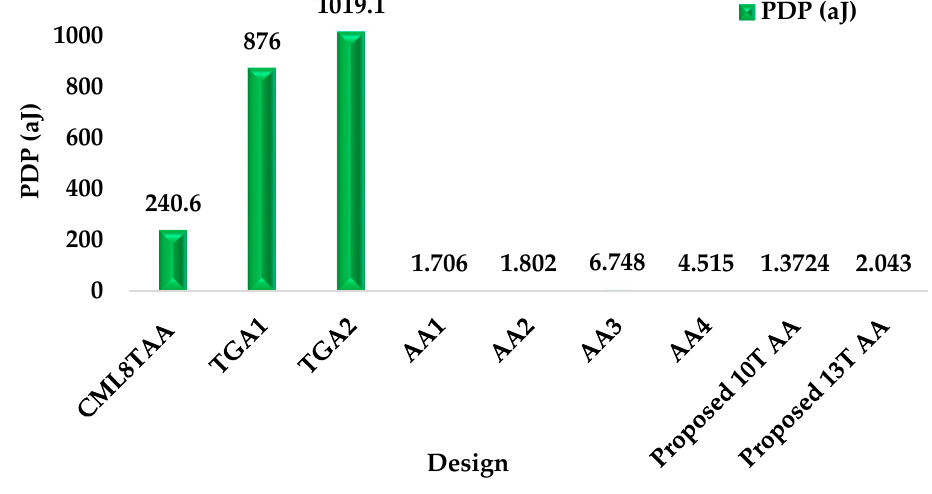
Figure 12. PDP (aJ) vs. existing and proposed circuits.